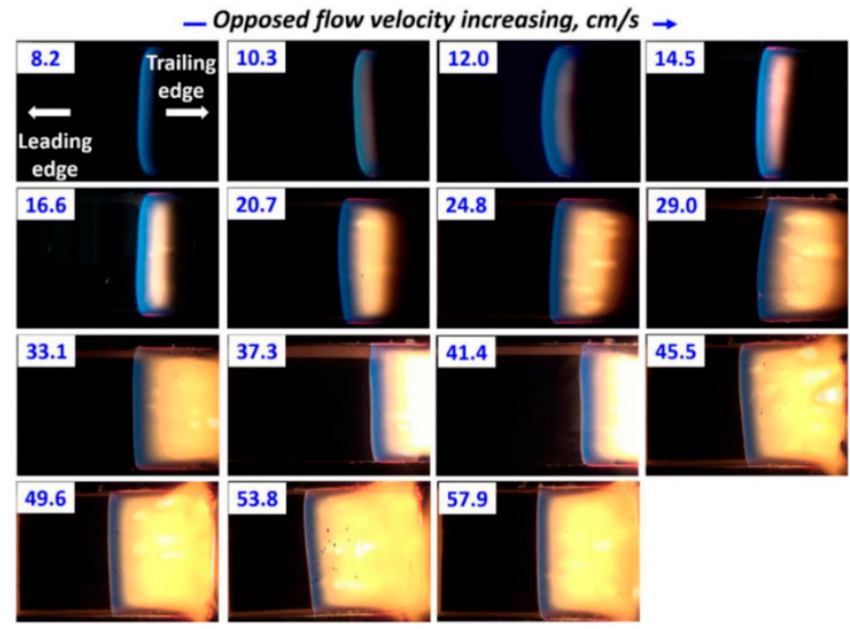
Figure 19. Flame images for a 24.5 mm sample Figure 23. Flame images for a 24.5 mm sample [159].